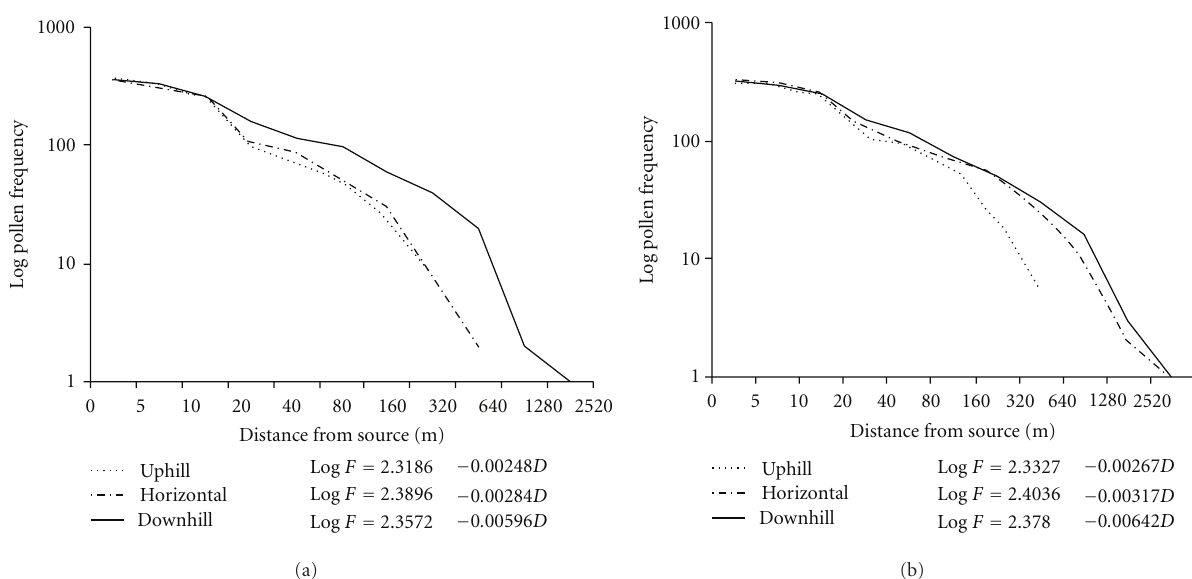
Figure 4: Pollen dispersion at di ff erent distances from source tree at lower and higher